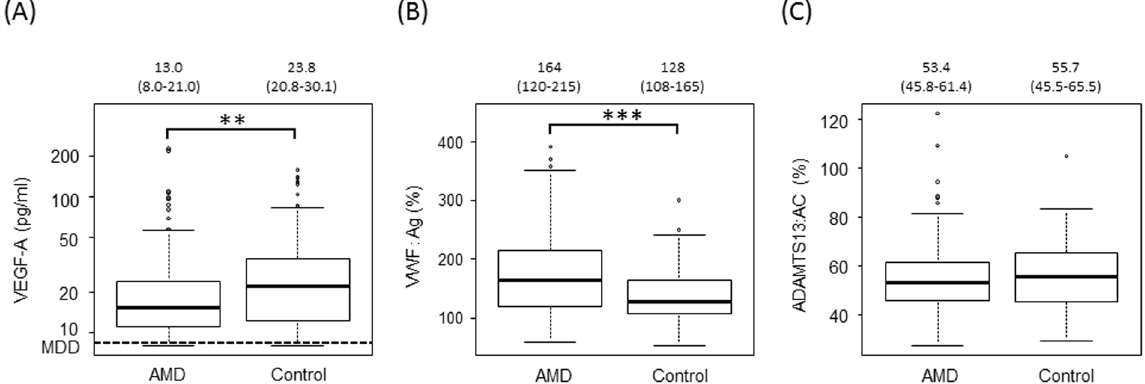
Figure 1. Plasma levels of VEGF-A, VWF antigen, and ADAMTS13 activity in patients with untreated exudative AMD and controls. ( A ) Plasma levels of VEGF-A in patients with AMD were significantly lower than those in controls ( ** p < 0.01). The minimum detectable dose (MDD) of VEGF-A defined by the manufacturer was 9 pg/ml. ( B ) Plasma levels of VWF antigen (:Ag) in patients with age-related macular degeneration (AMD) were significantly higher than those in controls ( *** p < 0.001). ( C ) Plasma ADAMTS13 activity (:AC) levels in patients with AMD were almost the same as those in controls.